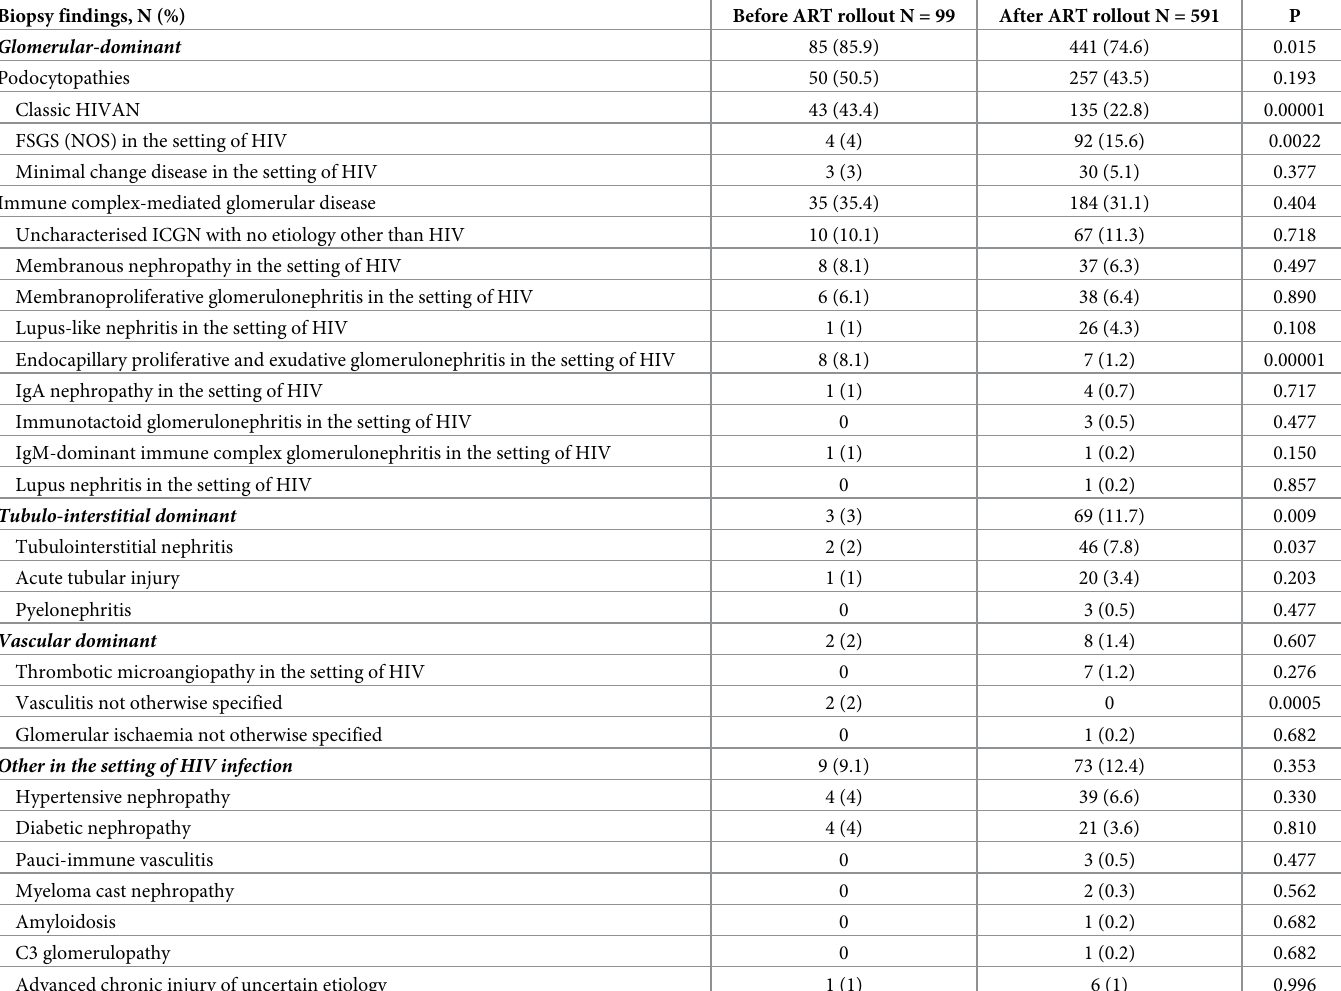
Table 3. Biopsy findings before and after ART rollout in HIV-positive patients (N = 690). Biopsy findings, N